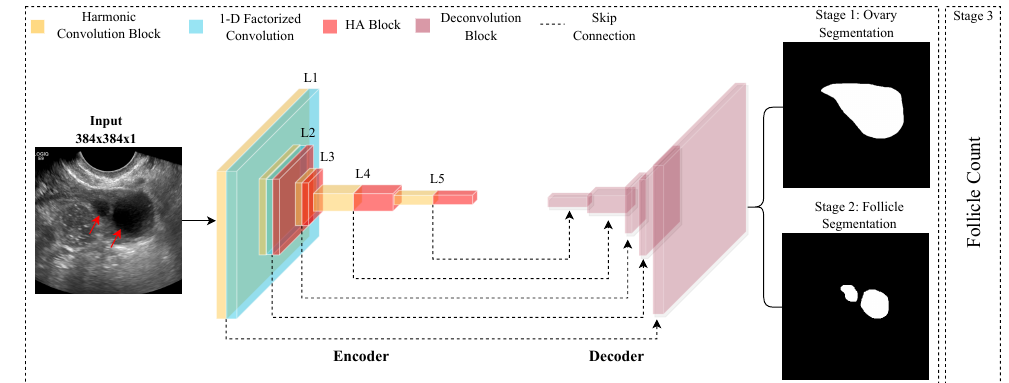
Figure 2. A general framework of ovarian ultrasound quantification. Here L n refers to the number of layers (i.e., 1 to 5) in the encoder network.